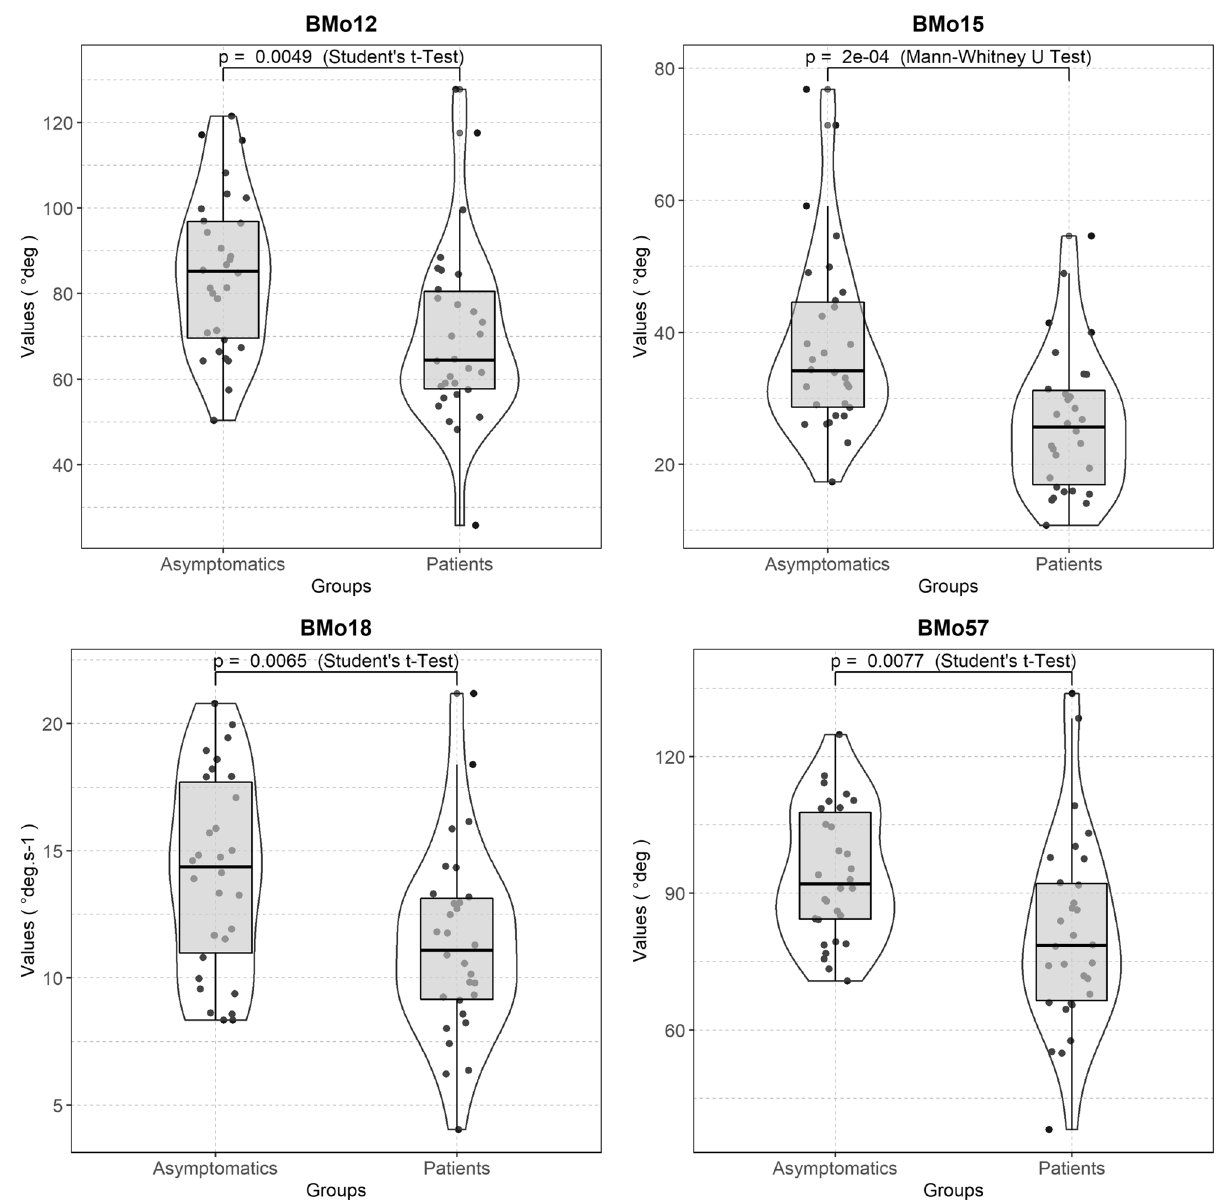
Figure 4. Boxplots summarising the values distribution measured on asymptomatic participants and NSLBP patients for the biomarkers having reached at least good levels in the reliabililty and validity domains.